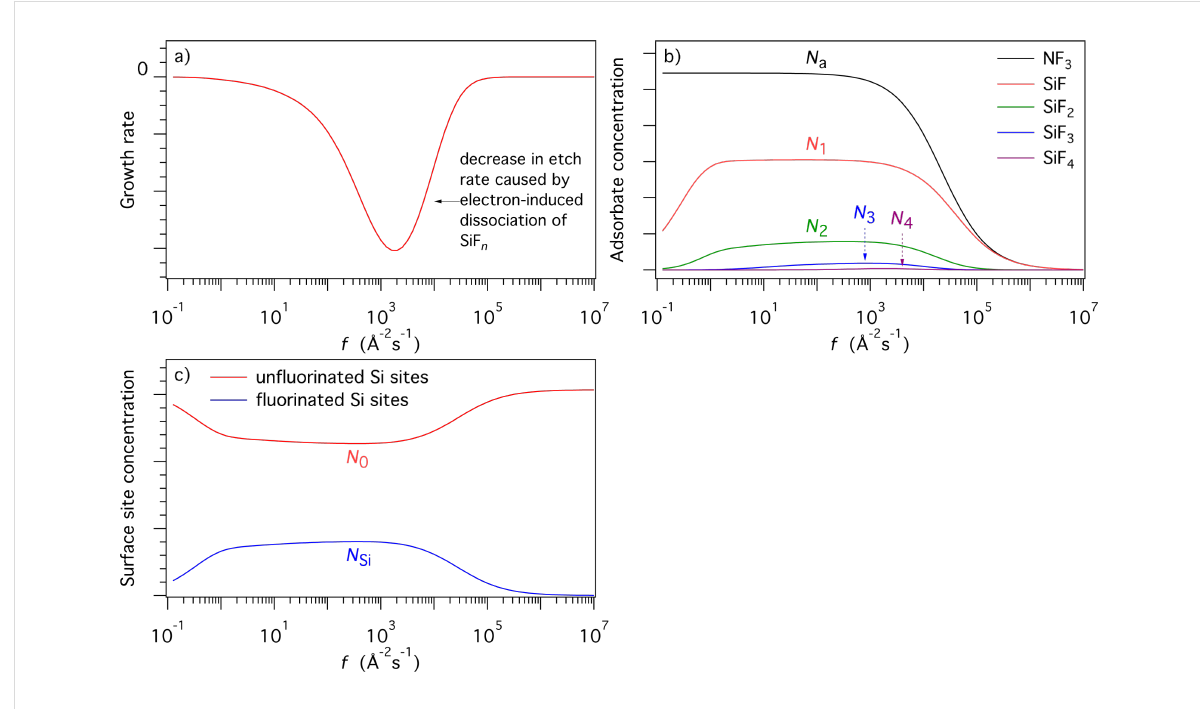
Figure 16: (a) Etch rate of Si calculated using Equation 61 as a function of electron flux f . (b,c) Corresponding steady state concentrations of NF 3 , SiF, SiF 2 , SiF 3 and SiF 4 molecules ( N a and N n ), fluorinated ( N Si ) Si sites, and unfluorinated ( N 0 ) and Si sites. ( T = 100 K, T g = 300 K. All other model input parameters were the same as in [2].)